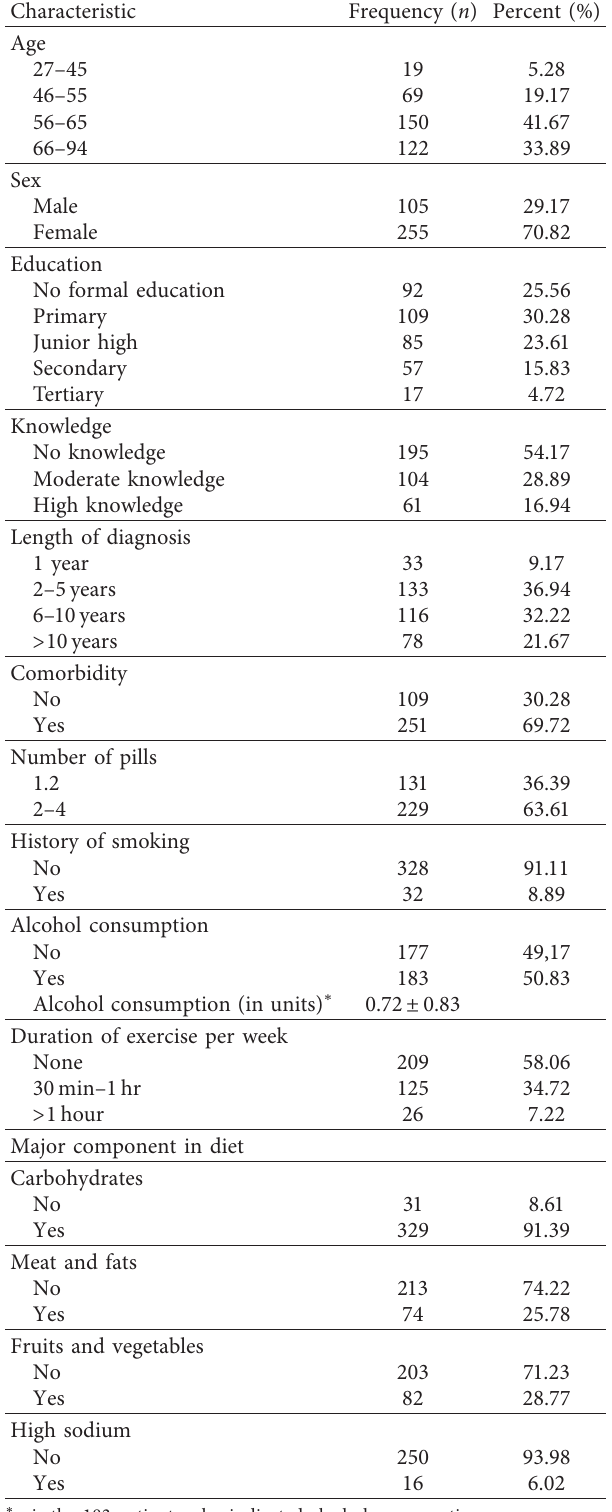
Table 1: Background characteristics of